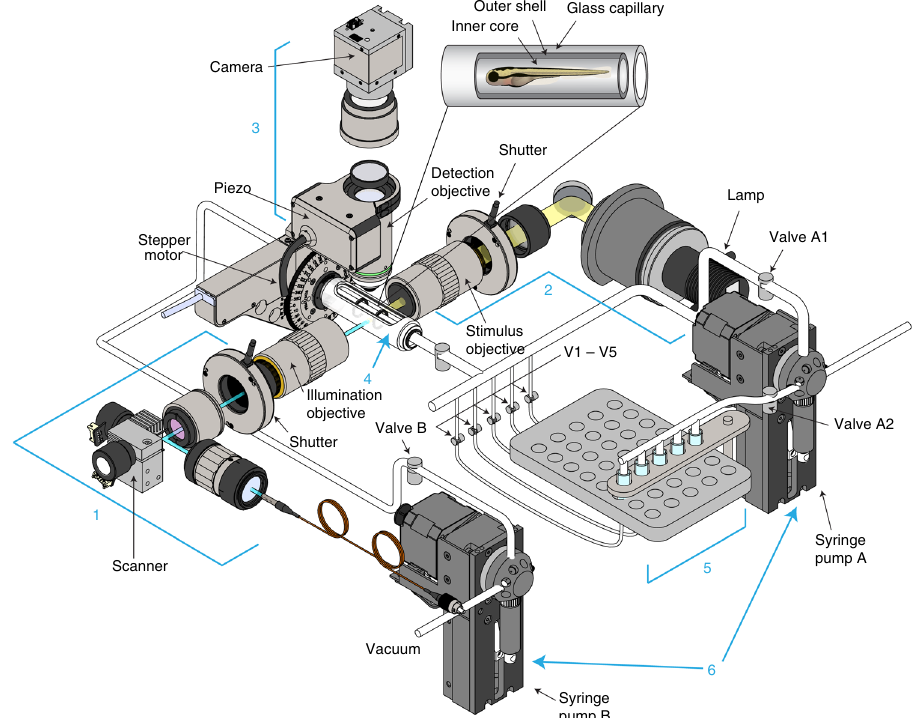
Fig. 1 High-throughput platform for functional brain connectivity-based drug screening. The platform consists of multiple incubation reservoirs in which zebra fi sh larvae (captured in a dual-layer polymer pellet) can be treated with compounds of interest and rapidly transferred back and forth and positioned in the imaging chamber of a high-speed light-sheet microscope. The platform has six parts: (1) an illumination arm consisting of a 488 nm fi ber laser, a 2D galvo scanner, a tube lens, a shutter, and a low NA ×4 objective. (2) A light-stimulus arm, consisting of a halogen lamp, a fi lter, a tube lens, a fast shutter to deliver brief light pulses, and a ×4 objective. (3) A detection arm, consisting of a ×16 water immersion objective, a piezo scanner, a 525 nm fl uorescent fi lter, a tube lens, and a high speed sCMOS camera. (4) An imaging chamber, consisting of an ultra-thin wall glass capillary running through a custom- made watertight glass-sided aluminum chamber. The glass capillary is connected to a stepper motor for rotational alignment of the larva. (5) Multiple reservoirs for incubating agarose-embedded zebra fi sh larvae in drugs. When an incubation chamber is connected to the imaging chamber (via opening